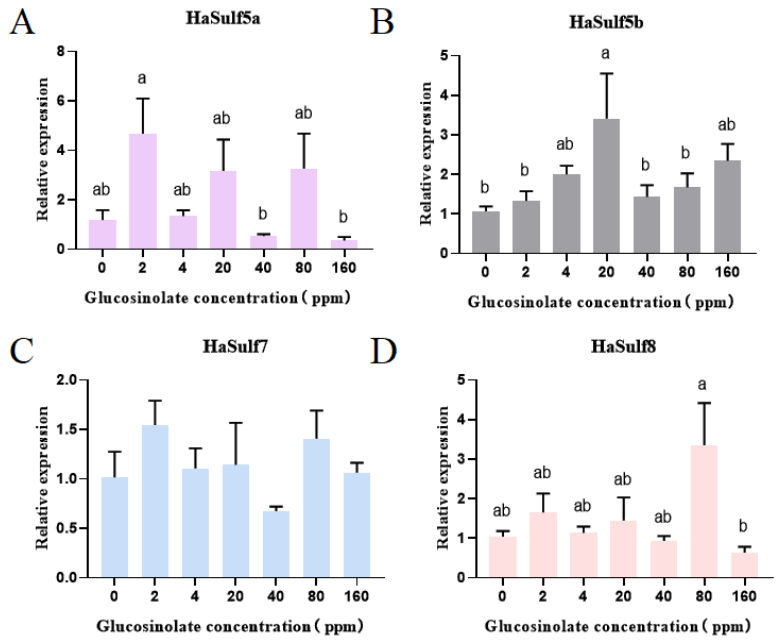
Figure 7. The effect of different concentrations of glucosinolate on the expression of HaSulfs gene family. The picture shows the expression level of HaSulfs gene family after feeding different concentrations of glucosinolate. ( A ) The relative gene expression of HaSulf5a . ( B ) The relative gene expression of HaSulf5b . ( C ) The relative gene expression of HaSulf7 . ( D ) The relative gene expression of HaSulf8 . Error bars indicate the standard error of the mean (SEM) ( n = 5). Lowercase letters indicate significant difference at p < 0.05 (One-way